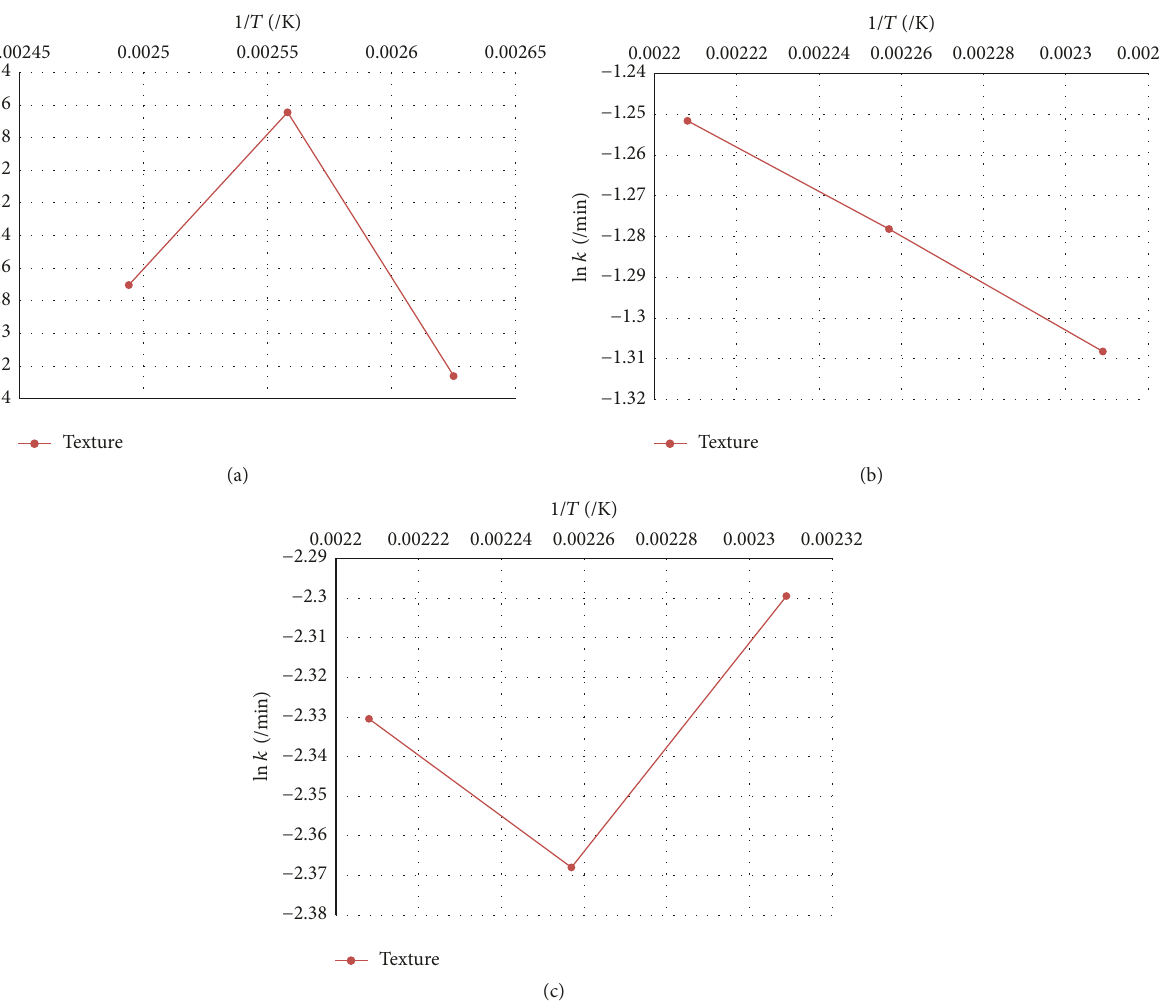
Figure 6: (a) Arrhenius plot relating rate constants with frying temperatures at vacuum conditions for texture (hardness) of YFCC. (b) Arrheniusplotrelatingrateconstantswithfryingtemperaturesatatmosphericfryingconditionsfortexture(hardness)ofYFCC.(c)Arrhenius plot relating rate constants with frying temperatures at atmospheric frying conditions for texture (hardness) of predried YFCC.